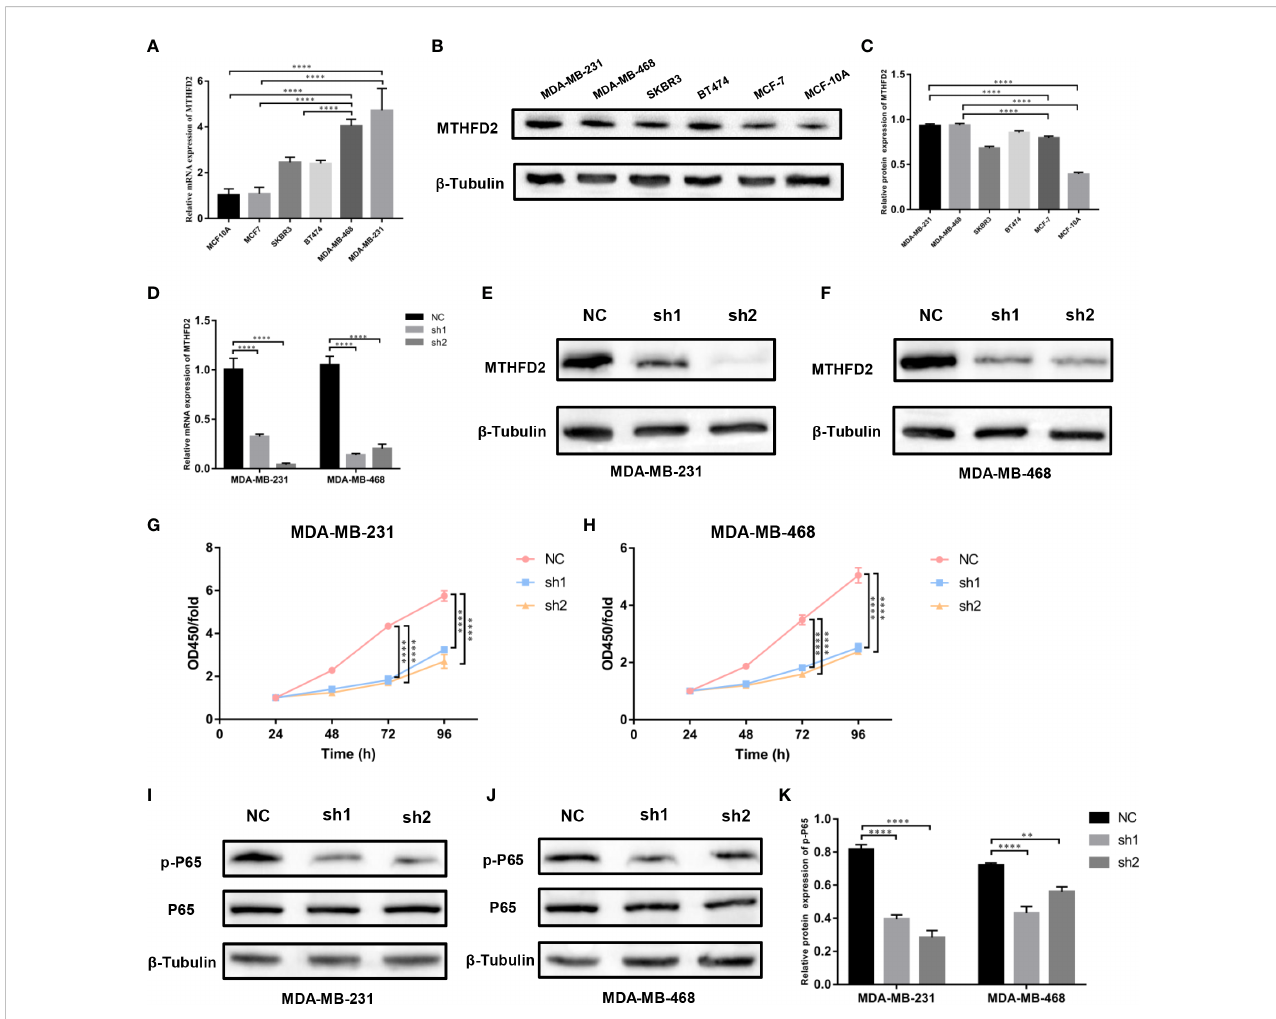
FIGURE 8 Expression levels of MTHFD2 in various breast cancer cell lines, construction of MTHFD2 knockdown cell lines, and cell proliferation assay. (A) Determination of MTHFD2 mRNA expression levels in normal breast cell lines (MCF-10A) and breast cancer cell lines (BT474, MDA-MB-468, MCF7, SKBR3, and MDA-MB-231). (B, C) Determination of MTHFD2 protein expression levels in normal breast cell lines (MCF-10A) and breast cancer cell lines (BT474, MDA-MB-468, MCF7, SKBR3, and MDA-MB-231). (D) RT-qPCR was used to verify the knockdown effect of MTHFD2 mRNA in MDA-MB-231 and MDA-MB-468 cell lines. (E, F) Western blot assay veri fi ed the knockdown effect of MTHFD2 protein in MDA-MB-231 and MDA-MB-468 cell lines. (G, H) CCK8 assays were used to detect the effect of MTHFD2 knockdown on the viability of MDA-MB-231 and MDA-MB-468 cell lines. (I-K)